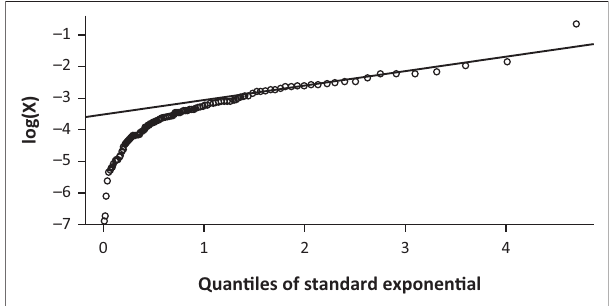
FIGURE 1: Pareto Quantile-Quantile diagram for determining the threshold for positive returns (left tail or gains).